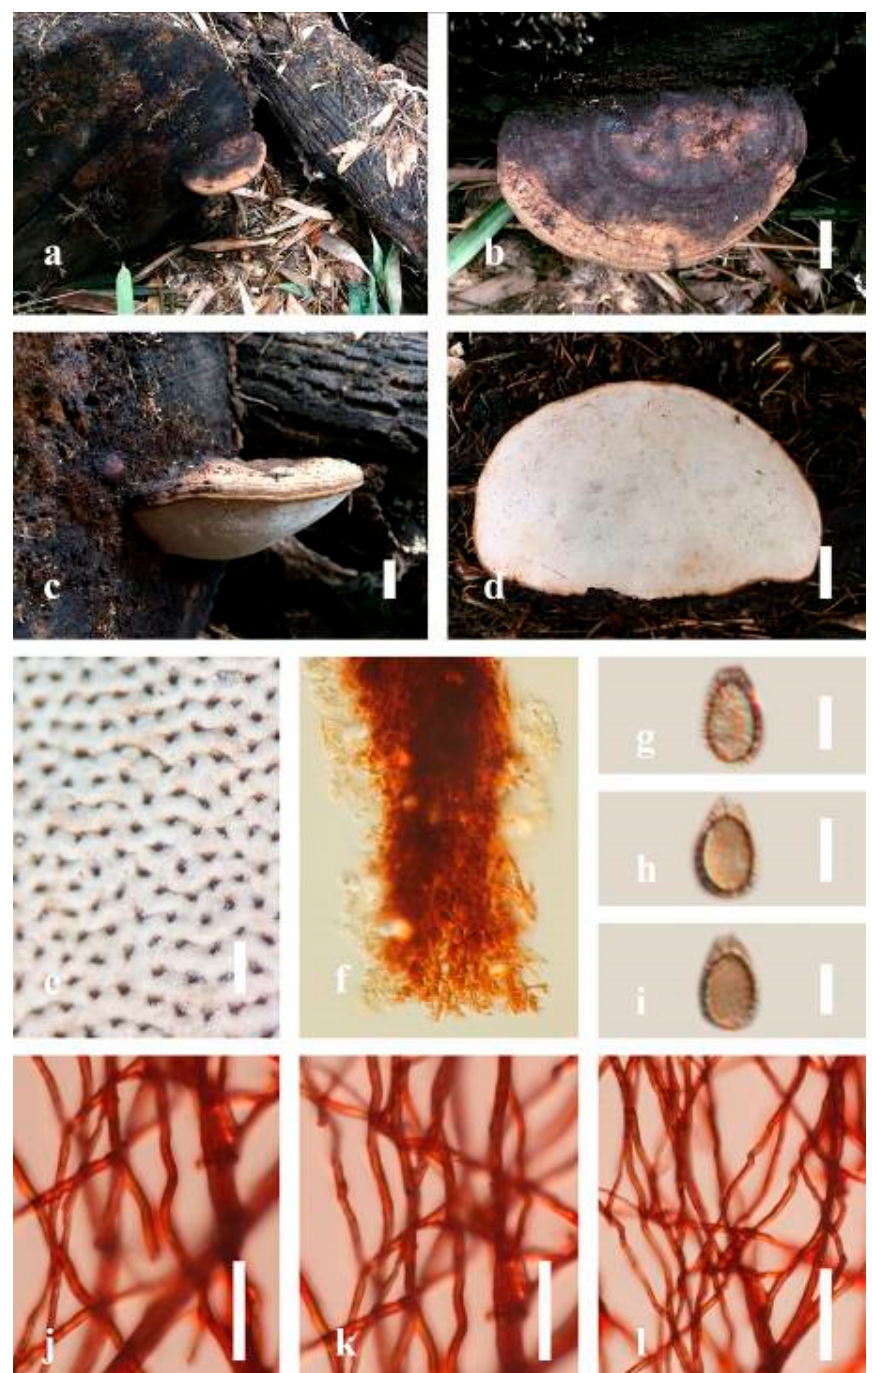
Figure 8. Morphology of Ganoderma gibbosum (HKAS 97411): ( a , b ) upper surface of mature basidiomes; ( c ) margin; ( d ) under surface of mature basidiomes; ( e ) pore characteristics; ( f ) hyphae of tube layers in Melzer’s; ( g – i ) basidiospores in Melzer’s; ( j – l ) context hyphae in Congo red. Scale bars: ( b , d ) = 3 cm, ( c ) = 1 cm, ( e ) = 500 μ m, ( g – i ) = 5 μ m, ( j – l ) = 20 μ m. Ganoderma leucocontextum T.H. Li, W.Q. Deng, Sheng H. Wu, D.M. Wang and H.P. Hu, Mycotaxon 56: 82 (2015) (Figure 9) Facesoffungi number: FoF 06247 Description: Basidiomes flabelliform, subdimidiate, stipitate. Pileus 6–14 cm in length, 4–12 cm in width, and 1–3.2 cm thick. Pileus flabelliform, spathulate, stipitate, subdimidiate to dimidiate, umbonate, somewhat semicircular, plump, concentrically sulcate zone,